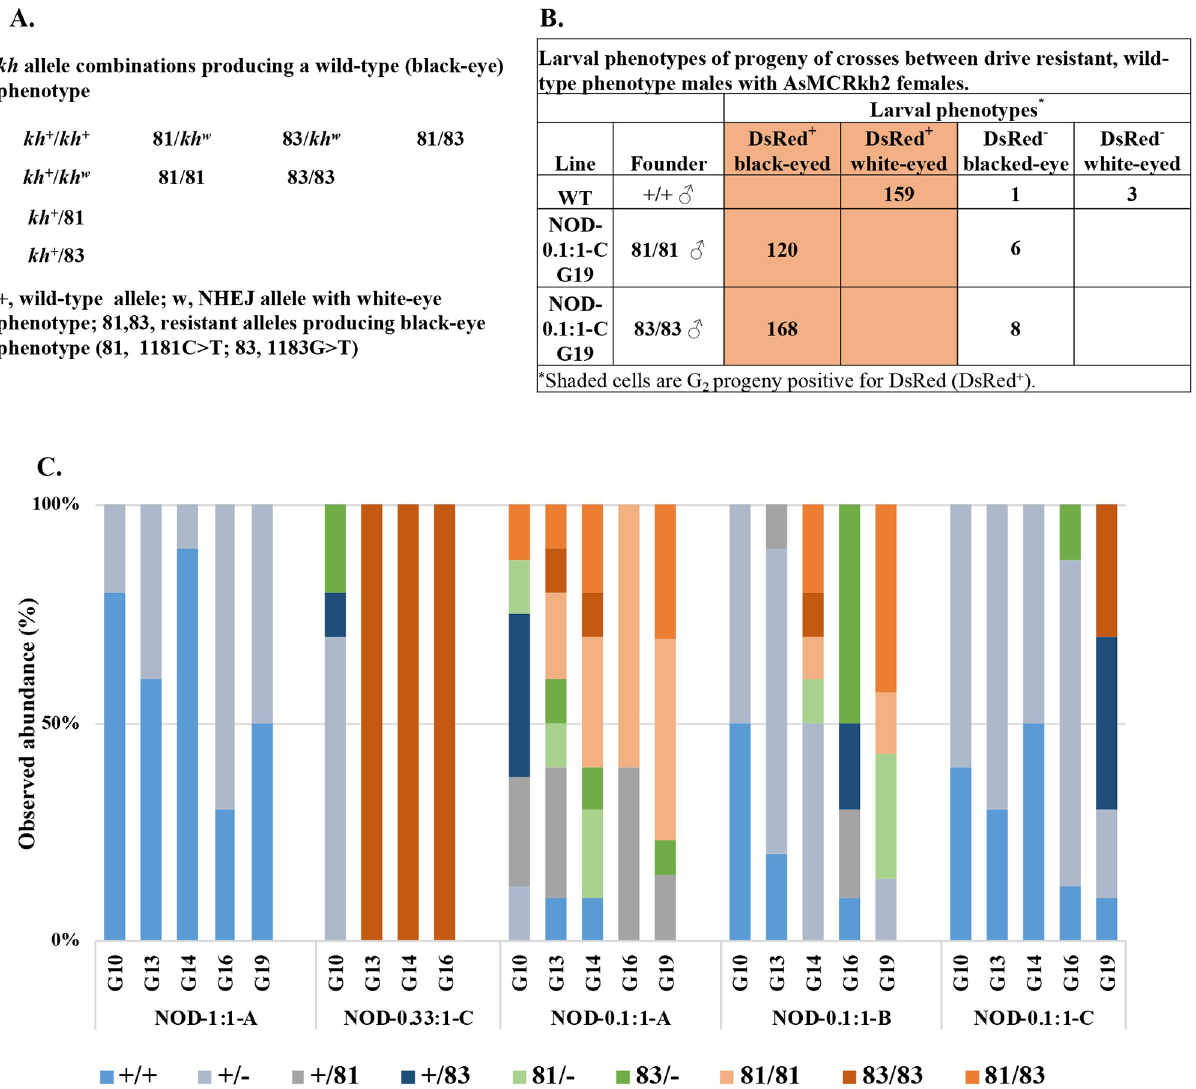
Fig 6. Wild-type kh drive-resistant genotypes and phenotypes at later generations of non-overlapping gene drive (NOD)cage trials. Randomly- selected samples of ~10 mosquitoes that had DsRed-negative (DsRed - )/ black-eyed ( kh + ) phenotypes from each cage were sequenced to analyze the kh2 target site. Two point mutations recovered as wild-type phenotypes were identified as 1181C > T (designated 81), which results in a silent mutation at Y328, and 1183G > C (designated as 83), which causes a substitution of its neighbor amino acid G329A. (A) Combinations of 81 and 83 alleles that result in wild-type phenotypes. (B) Larval phenotypes of progeny from crosses between DsRed - /black-eye (DsRed - / kh + ) individual mosquitoes homozygous for the drive-resistant alleles and homozygous AsMCRkh2 females (DsRed + / kh w ). (C) Percentages of each genotype present in each cage.